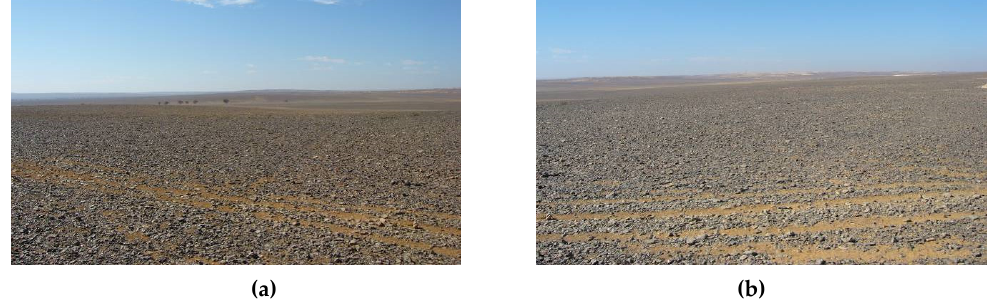
Figure 8. Nature of the area at Qaser Amra; ( a ) View 1; ( b ) View 2.